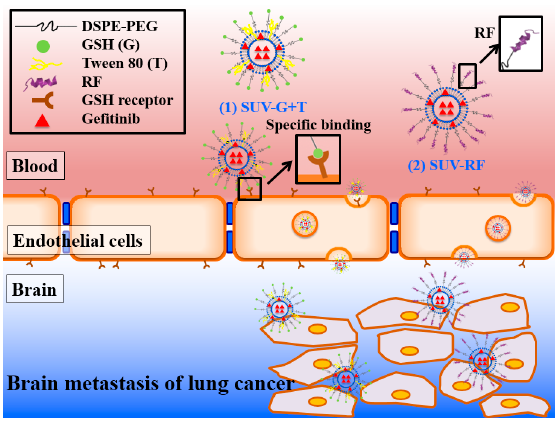
Figure 8. Schematic illustration of delivery of gefitinib-loaded PEGylated liposomes across the BBB. SUV-G+T and SUV-RF may bind to receptors expressed on the surface of brain endothelial cells, enhance gefitinib transport across the BBB, and target to tumor sites.